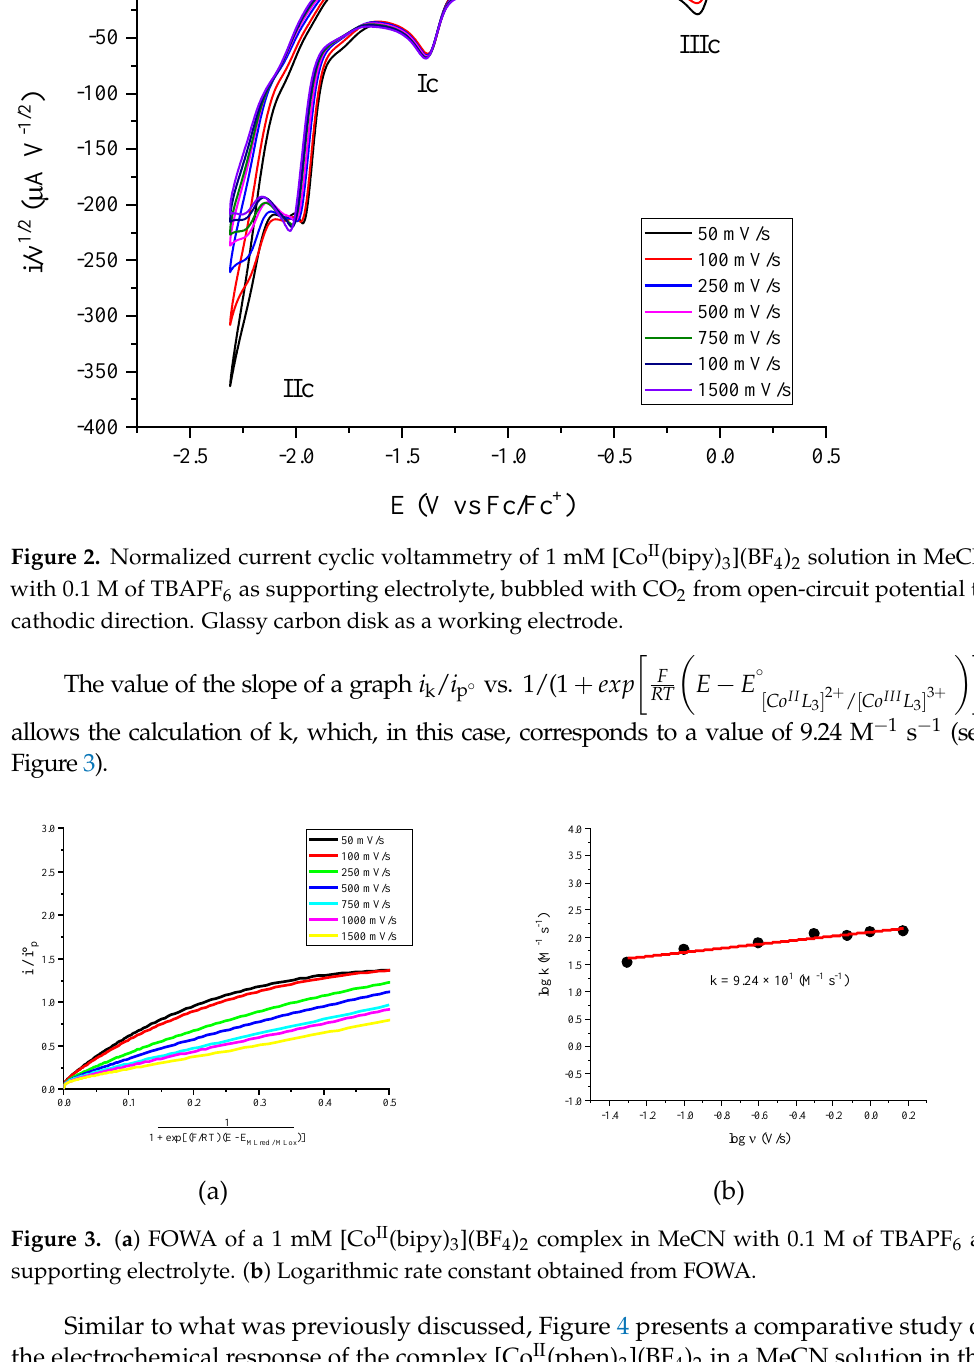
Figure 2 . Normalized current cyclic voltammetry of 1 mM [Co II (bipy) 3 ](BF 4 ) 2 solution in MeCN with 0.1 M of TBAPF 6 as supporting electrolyte, bubbled with CO 2 from open-circuit potential to cathodic direction. Glassy carbon disk as a working electrode.